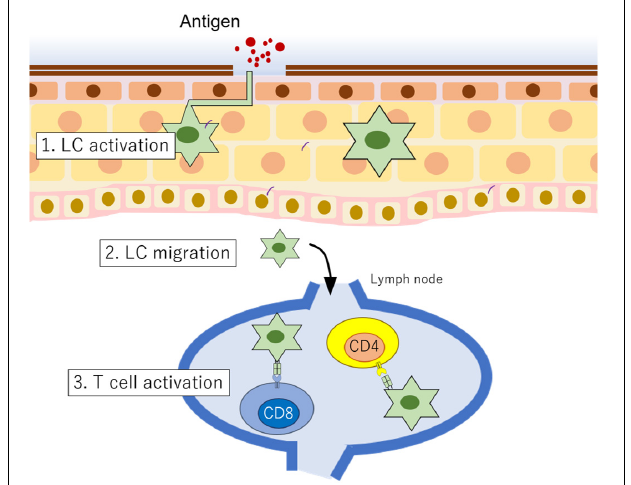
What is the skin phenotype when primary cilia are